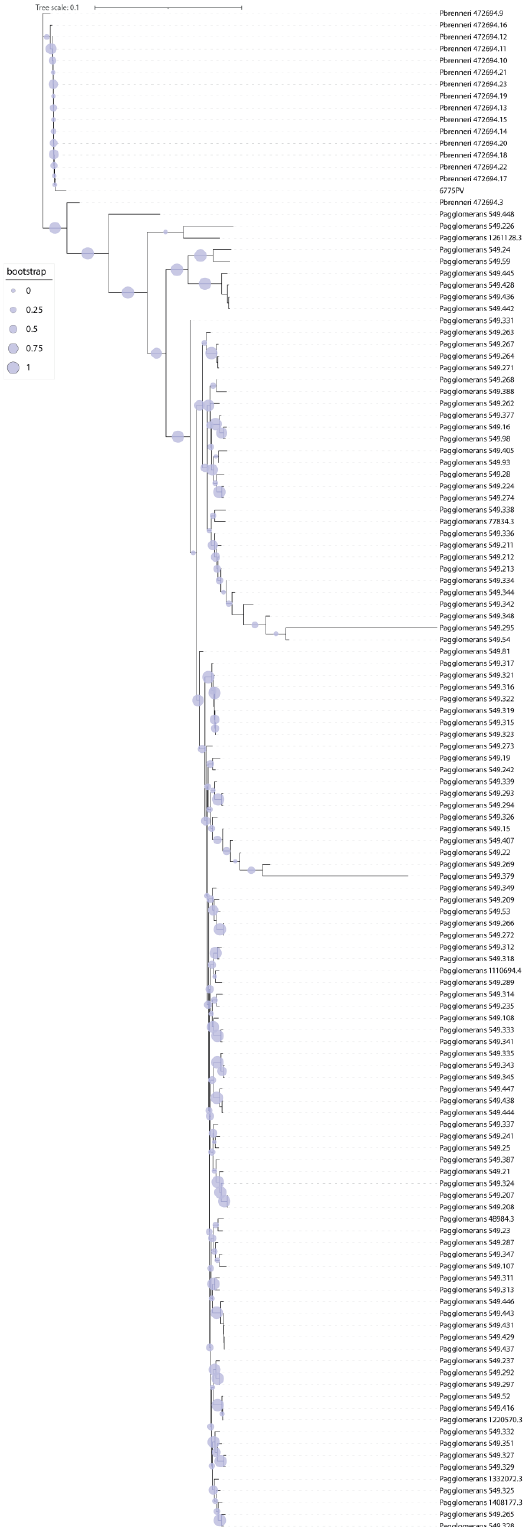
Figure 2. Phylogeny of the genome of isolate 6775PV and all high-quality genomes of the P. agglomerans and P. brenneri species. The Phylogeny was obtained using the software JolyTree. Bootstrap values are represented with colored dots of variable size on the tree